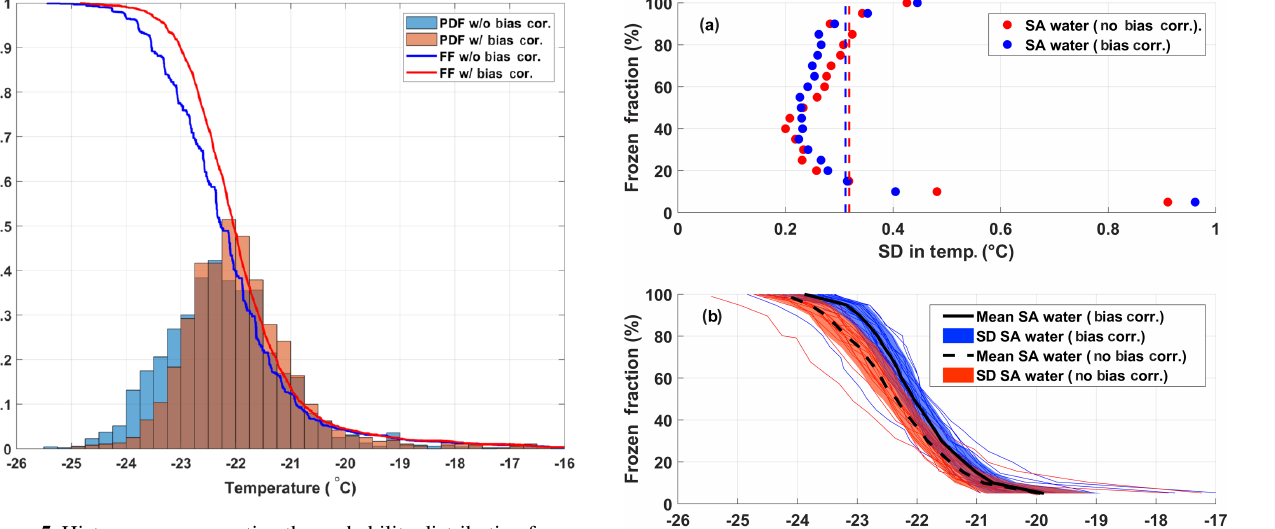
Figure 5. Histograms representing the probability distribution func- tions for freezing temperatures of the 20 SA water experiments without (blue bars) and with (red bars) the bias correction. The cal- culated cumulative distribution functions, or frozen fraction curves without and with the bias correction, are represented as the blue and red lines, respectively.